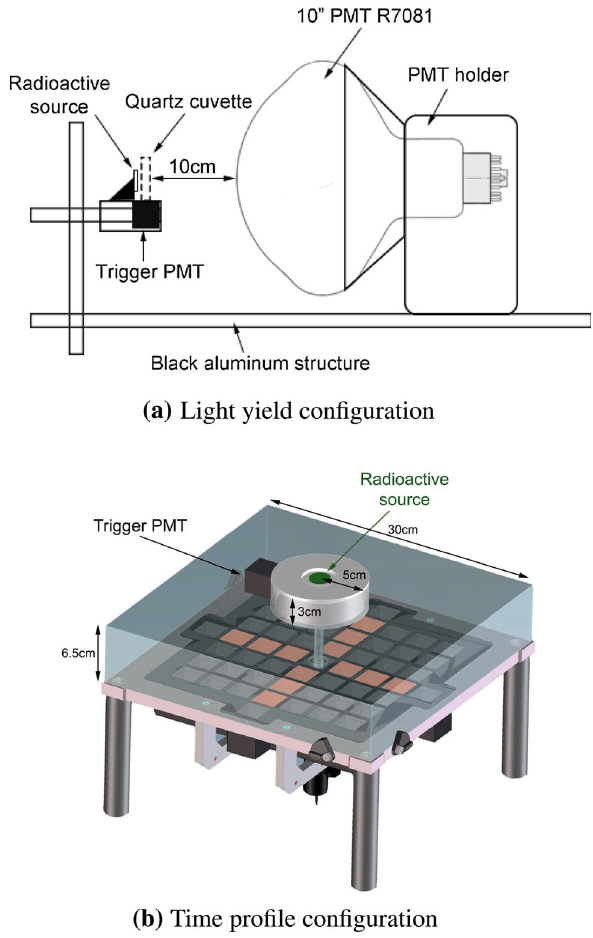
Fig. 1 Experimental configurations used in this analysis. Top: scintil- lation light yield setup; bottom: scintillation time profile configuration. The four scintillator panels that surround the time profile setup on two sides and the bottom are not shown in this figure and we refer to [4] for technical drawings of their layout. See Sects. 3.1.1 and 3.2.1 for further